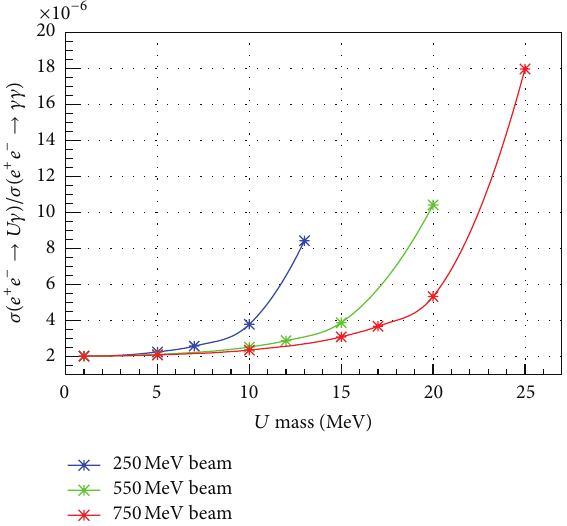
Figure 9: Ratio of the 𝑈 boson production (for 𝜖 = 10 −3 ) and two- photon annihilation cross section as a function of the 𝑈 boson mass for different beam